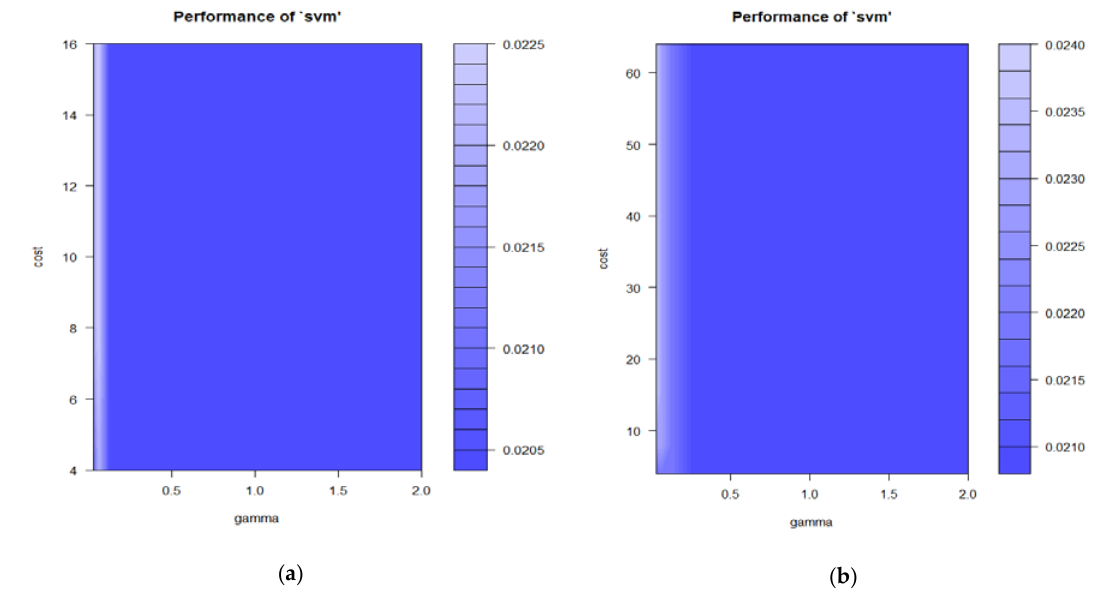
Figure A3. Parameter tuning for the postulated SVM plot: partial variables with the moving window and expanding window methods. ( a ) parameter tuning for the SVM plot of the partial variables with the moving window method in the final loop calculation; ( b ) parameter tuning for the SVM plot of the partial variables with the expanding window method in the final loop calculation.